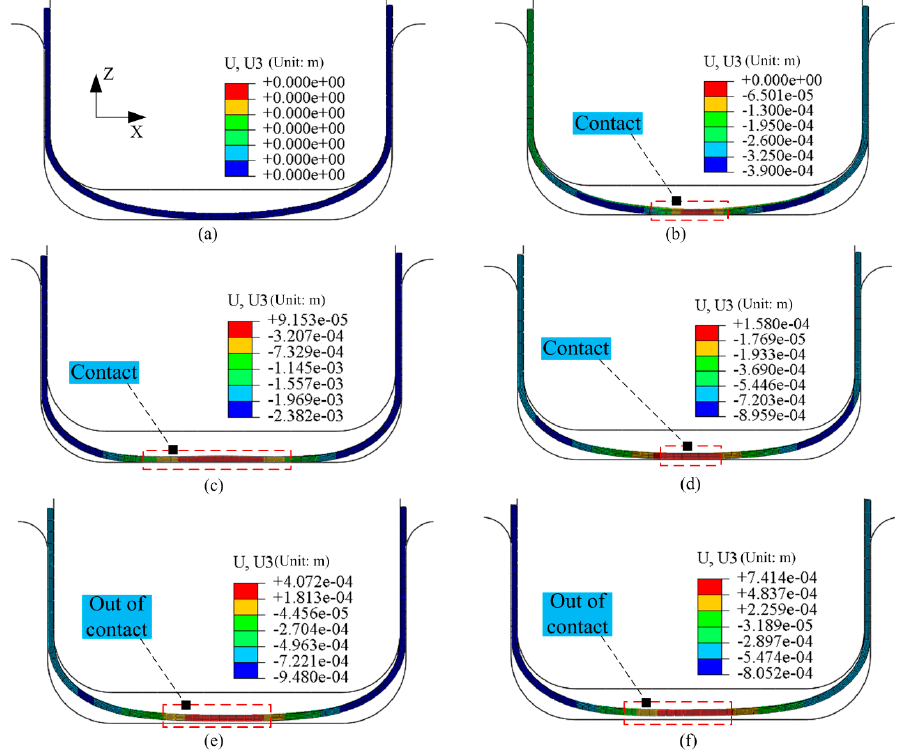
Figure 5. Distribution of displacement in the sheet for 1.5 kV at different times: ( a ) 0 μ s, ( b ) 75 μ s, ( c ) ( c ) 300 µ s, ( d ) 600 µ s, ( e ) 1500 µ s, and ( f ) 3000 µ